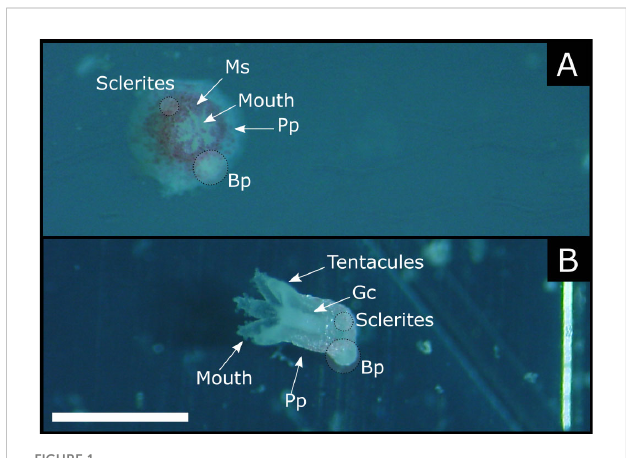
FIGURE 1 Living 1-month old recruits. (A) orthogonal view of the folded polyp. (B) lateral view of the open polyp. Ms, mesenteric septa; Pp, primary polyp; Bp, budding polyp; Gc, gastric cavity (scale bar 1 mm).